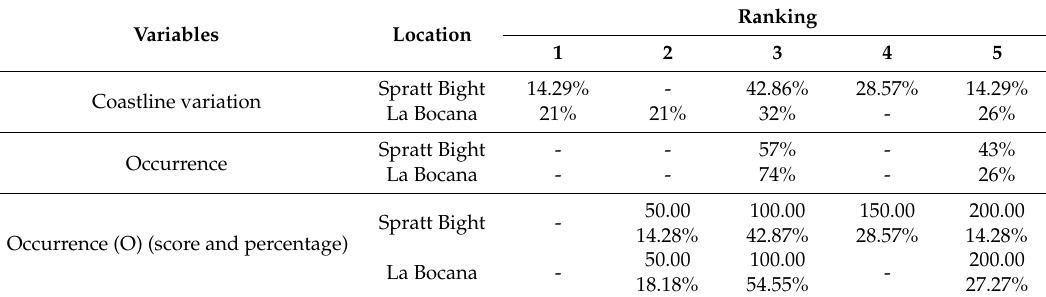
Table 5. Results of the occurrence component of the coastal erosion hazard, by study area, ranking, and final score obtained. The percentage represents the number of segments on each ranking over the total number of